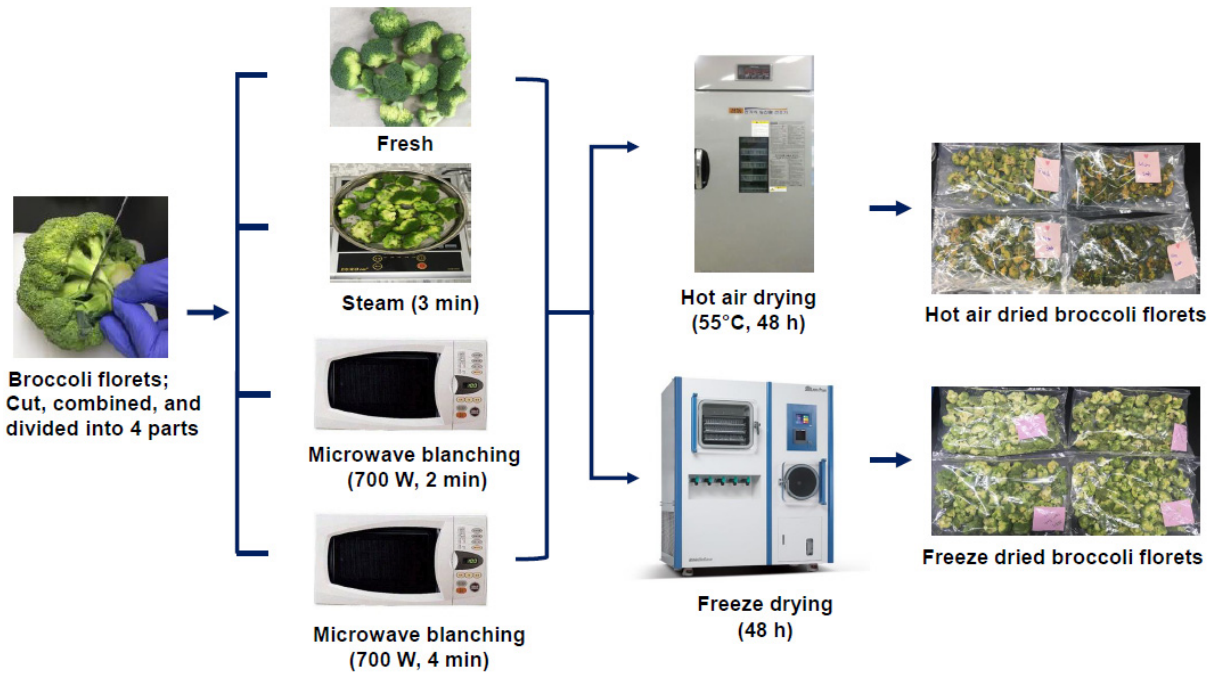
Figure 1. Flow diagram of the cooking and processing methods used for broccoli in the present study.